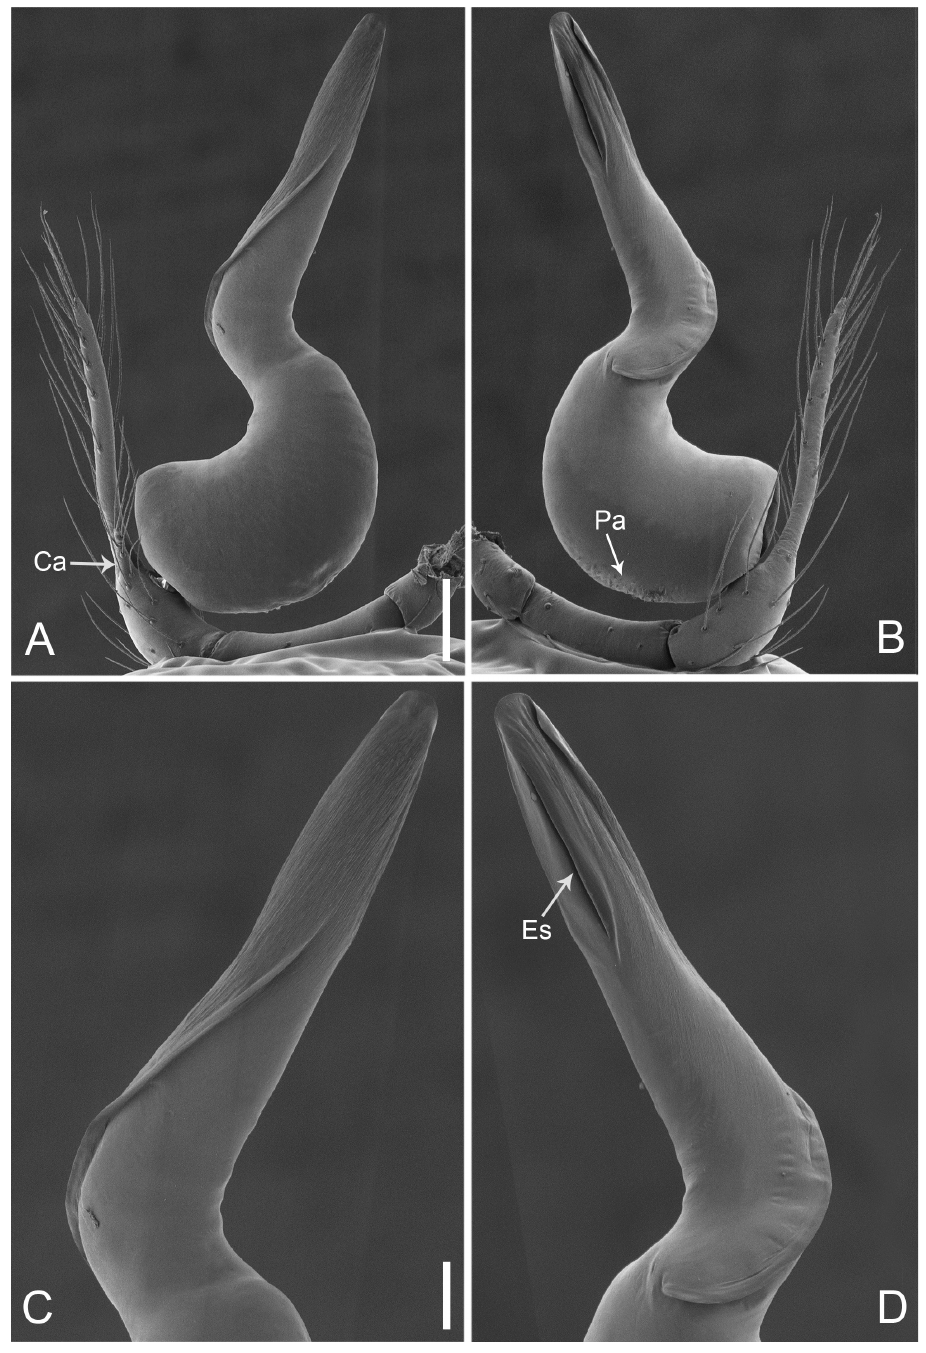
Figure 18. Pinelema wangshang Zhao & Li, sp. n., male. A Palp, prolateral view B Palp, retrolateral view C Embolus, prolateral view D Embolus, retrolateral view. Scale bars: 0.1 mm ( A–B ), 0.05 mm ( C–D